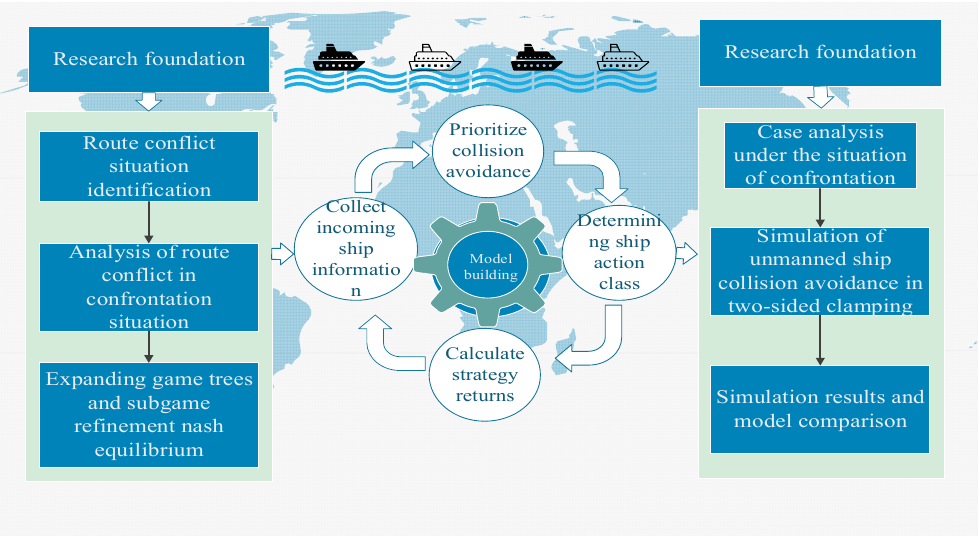
Figure 1. Research process.